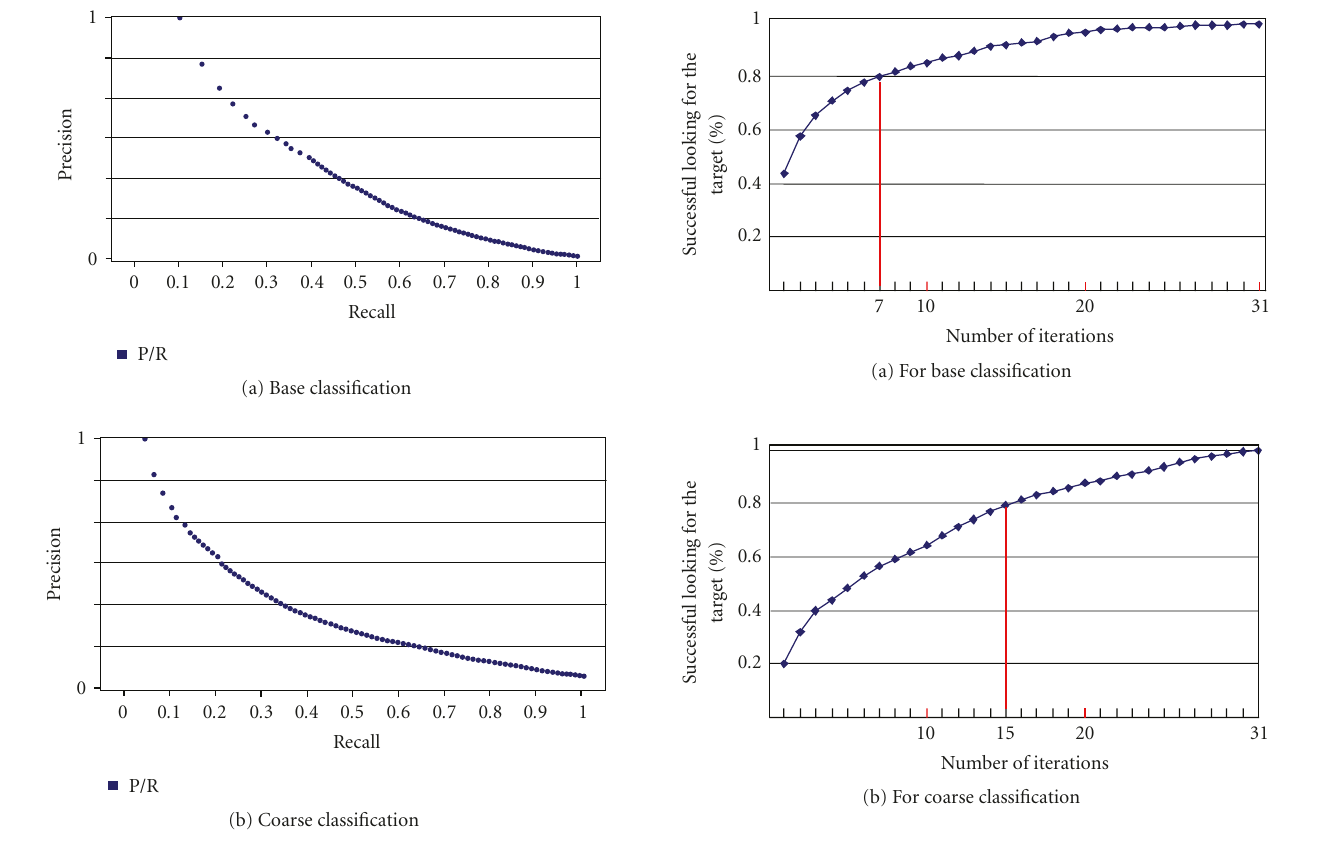
Figure 8: Evaluation for target search: percentage of successful search with respect to the number of